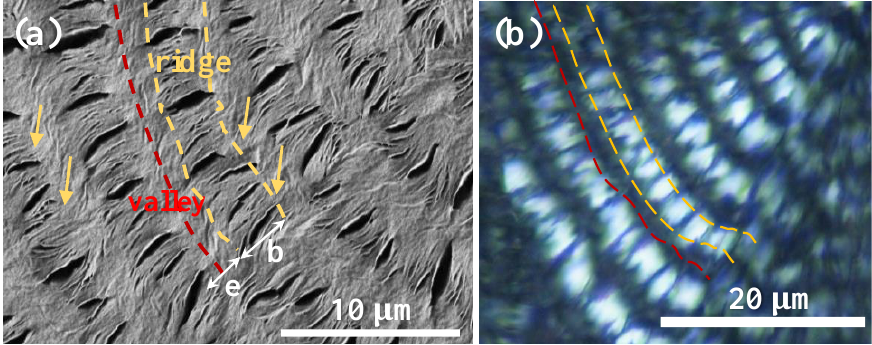
Figure 3. ( a ) SEM graph, and ( b ) oil-contact POM graph (with no tint plate) of top surface of PBA/PEO (90/10) crystallized at 30 °C. [Oil-contact POM at max. magnification of 2000×].